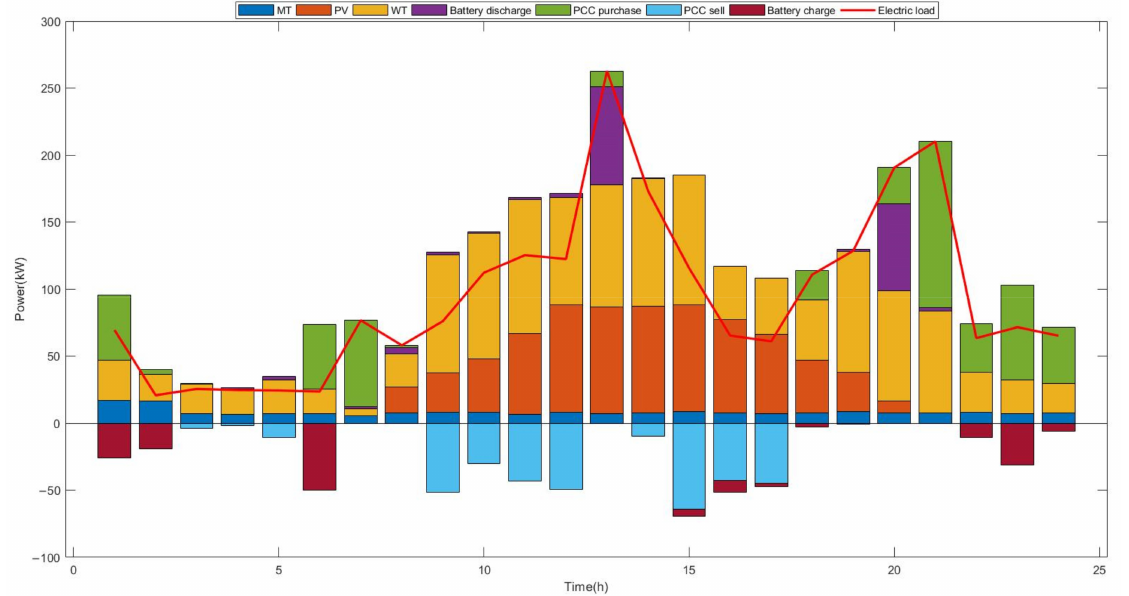
Figure 5. Optimal management of electrical elements of CHP